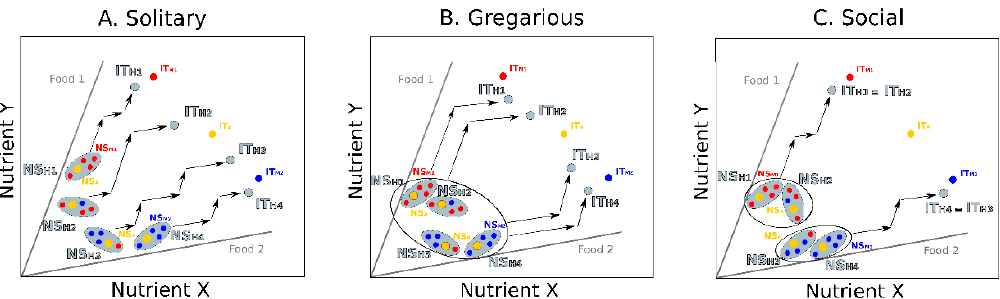
Figure 3. Integrating microbiota, host nutrition and social behavior. Populations of holobionts are represented in a nutrient space defined by two nutrients. Foods (grey lines) are defined by their ratio in nutrients X and Y. Animal hosts (yellow dots), gut microbes (blue and red dots), and holobionts (grey surfaces) are characterized by their nutritional states (animal: NS A ; microbe: NS M ; holobiont: NS H ) and intake targets (animal: IT A ; microbe: IT M ; holobiont: IT H ). Black arrows illustrate the feeding decisions of each holobiont or sub-groups of interacting holobionts. Three hypothetical scenarios depict the expected nutritional interactions between gut microbes and hosts in groups of increasing social complexity. ( A ) In solitary species, where individuals feed independently and do not interact, the diversity of environmental microbes may generate a high variability in the NS H and the IT H of the different holobionts. Each holobiont can reach its IT H by alternating its intake of the two complementary foods. ( B ) In gregarious species, where individuals feed together and regularly interact, horizontal transmission of microbes may reduce inter-holobionts variability of NS Hs and IT Hs . In this example where individuals do not interact evenly, horizontal transmission favors the emergence of sub-groups (black circles) of highly interacting individuals with similar gut microbiota that can collectively reach their IT H . ( C ) In advanced societies, where individuals with different nutritional needs (e.g., young and adults, queens and workers) permanently co-occur, differential social interactions and continuous homogenization of gut microbiota through social contacts favor the emergence of classes of highly interacting individuals with distinct NS Hs and IT Hs (e.g., castes). Holobionts can cooperate with other holobionts from the same class to reach their common IT H